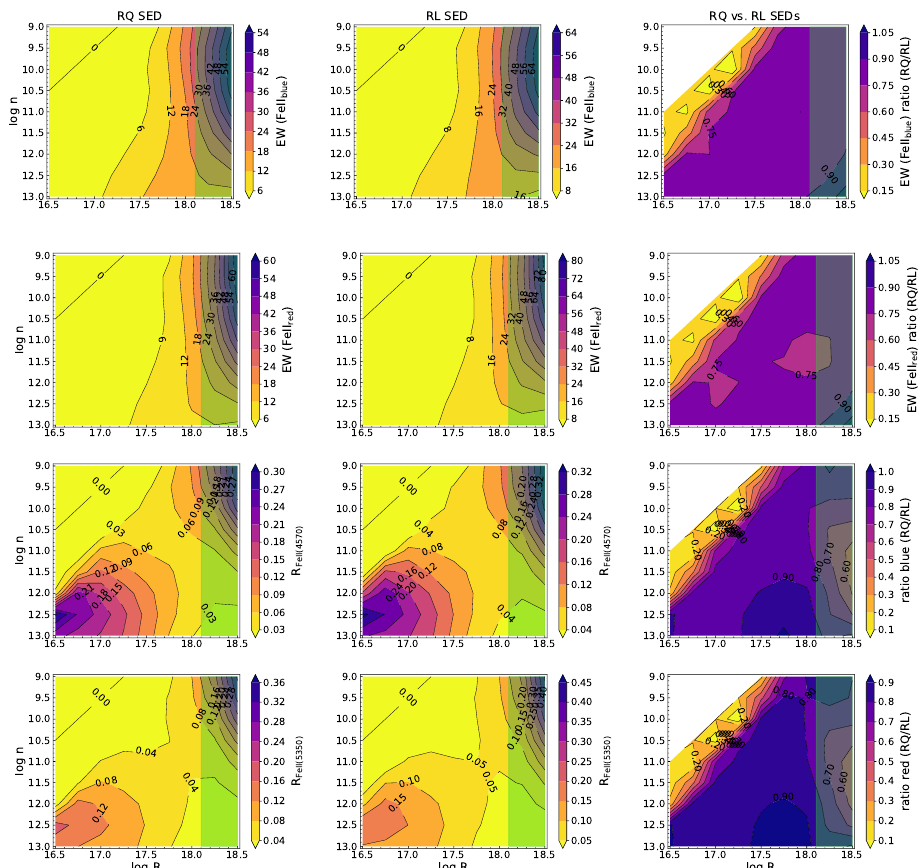
Figure A1. Results of CLOUDY simulations. First two rows: W(Fe II λ 4570) for RQ and RL (i.e., computed for the same physical parameters but with the two different SEDs of Laor et al. [88]) and their ratios; third and fourth row from top: R FeII , for RQ and RL and their ratios. Last four rows: same, for the red (R) Fe II blend peaked at λ 5312 Å.